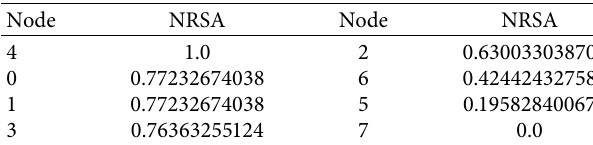
Table 2: Node importance table of the original